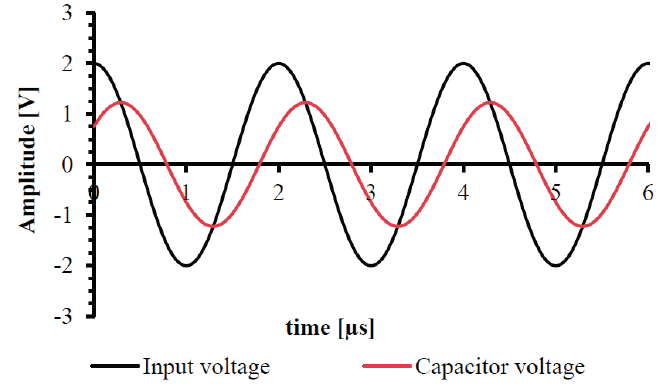
Figure 4. The response electrical field amplitude is smaller and shifted from the emitted field. The simulated RC-circuit is built with a 2 Ω resistor, a 412 pF/cm capacitor. The generator voltage is set at 2 Volts alternating at a frequency of 500